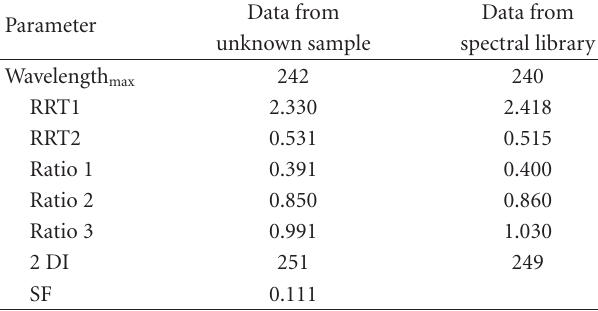
Table 4: The spectral fingerprint parameters of the unknown sample obtained by automated analytical